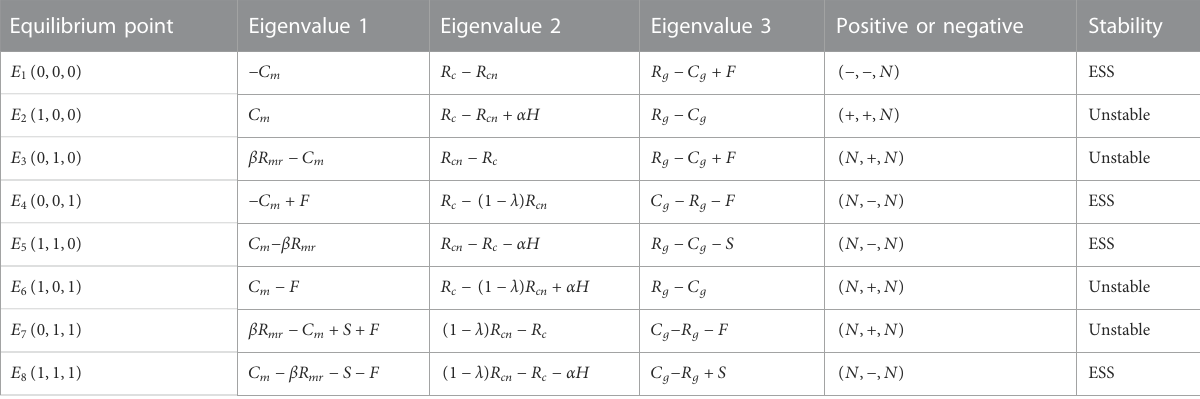
TABLE 2 Eigenvalues and stability of the game equilibrium